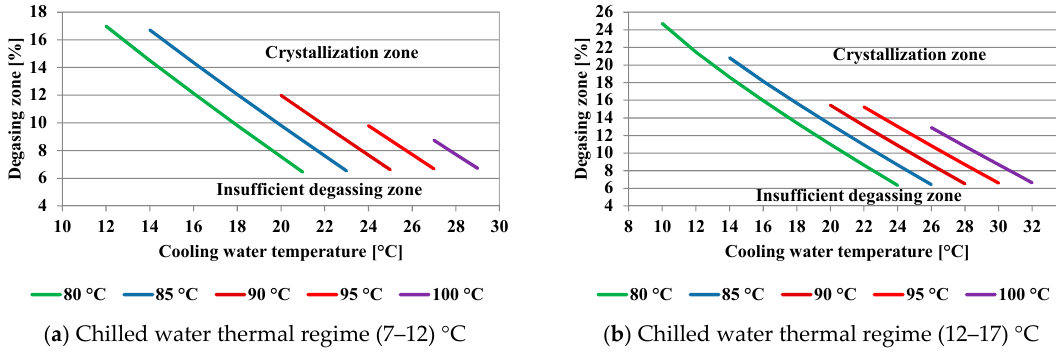
Figure 11. Influence of the cooling water and hot water temperature on the degassing zone.